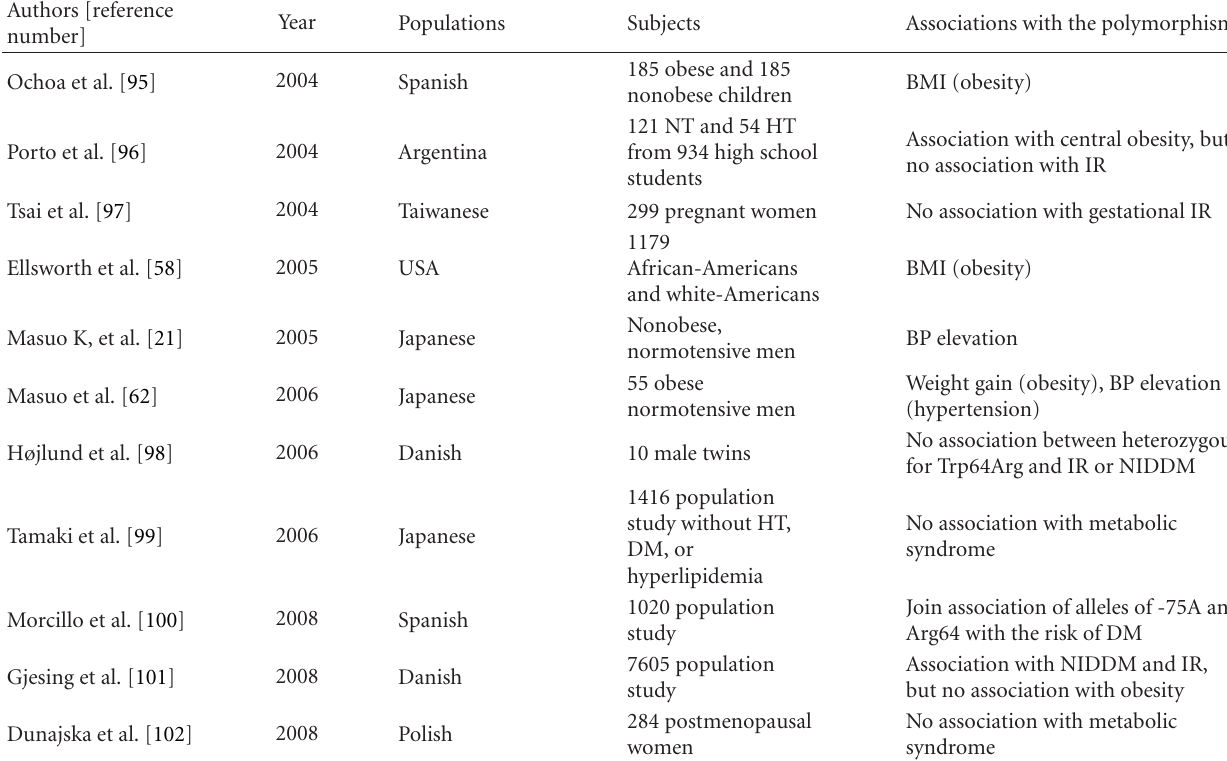
Table 5: Confounding variables considered to cause the discrepancy of the relationships between β -adrenoceptor polymorphisms and phenotypes of hypertension and metabolic syndrome in obesity.